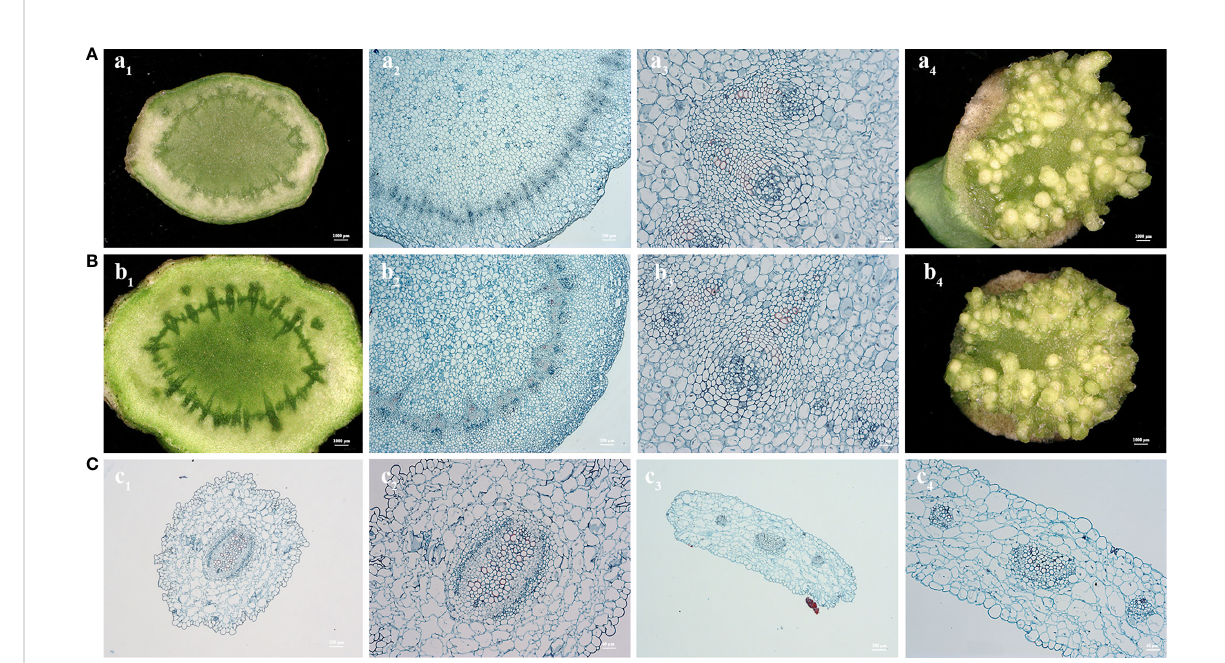
FIGURE 4 Cross section observation of paraf fi n embedded tissues from explants of curd peduncle (A, B) , hypocotyl and cotyledon petiole (C) . Cross section of fresh peduncle explants of C90IL-9 (A1-3) and B80IL-2 (B1-3). Shoot induction of peduncle of C90IL-9 (A4) and B80IL-2 (B4) after 10 days of culture in shoot induction medium. Cross section of fresh hypocotyl (C1-2) and cotyledon petiole (C3-4) explants of